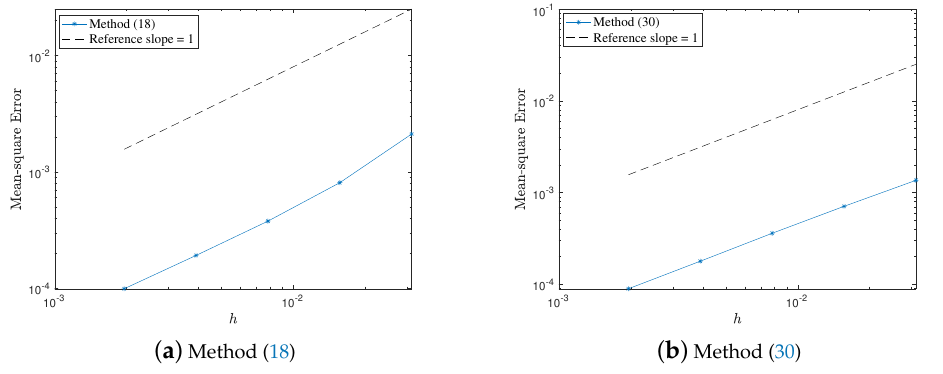
Figure 1. Mean-square convergence rate of methods (18) and